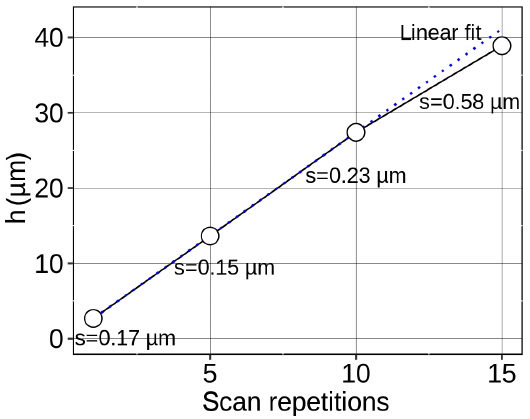
Figure 5. The figure depicts the measured path height vs. the num- ber of scan repetitions. The height of four samples for each number of scan repetitions was measured using a tactile profilometer. The arithmetic means of the measured heights as well as the SD (repre- sented using “s” in the figure) are shown. The dotted line represents a linear fit of points one to